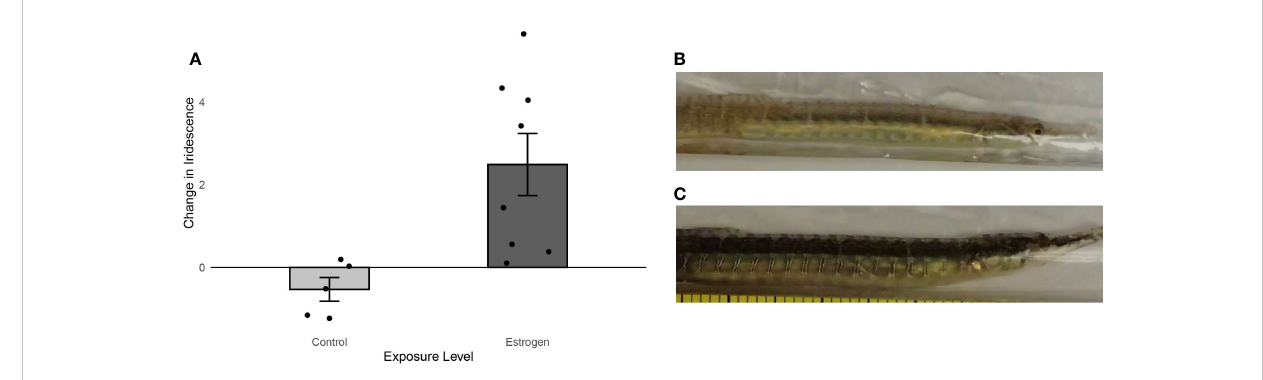
FIGURE 6 (A) Change in area of iridescence (± S.E.) for male pipe fi sh exposed to synthetic estrogen (n=8) and male pipe fi sh unexposed to estrogen (n=5). Exposed males showed a signi fi cant increase in iridescence. (B) Example of a male S. scovelli on Day 1 of the study and (C) that same male after 18 days of exposure to 5 ng/L of